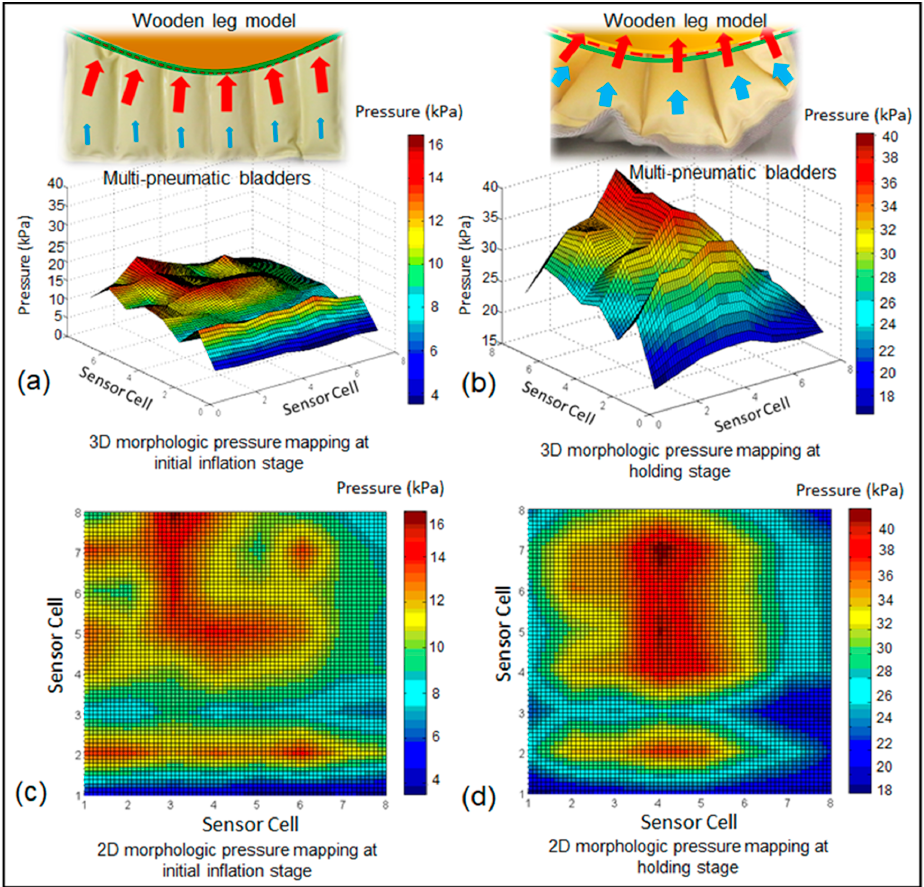
Figure 14. The 3D and 2D morphological pressure mapping detected by the developed dynamic interface pressure monitoring system at different stages of compression cycles by the IPC in vitro. ( a ) 3D morphologic pressure mapping at initial inflation stage, ( b ) 3D morphologic pressure mapping at holding stage, ( c ) 2D morphologic pressure mapping at initial inflation stage, ( d ) 2D morphologic pressure mapping at holding stage.